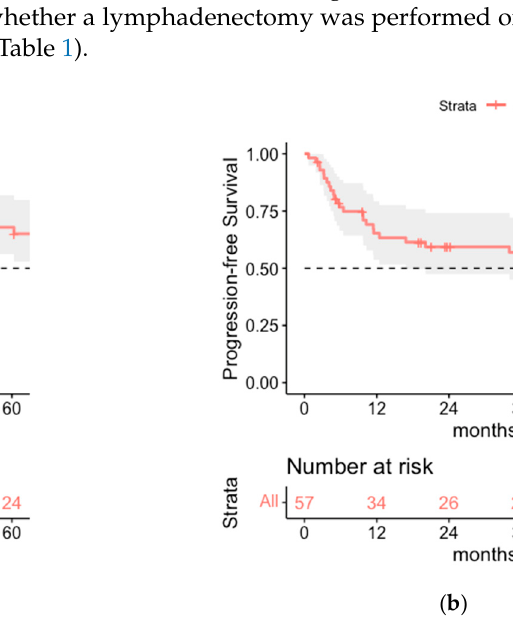
Figure 1. ( a ) Overall survival (OS) and ( b ) progression-free survival (PFS) of the total cohort (n = 57). Median OS was 112 months, median PFS was 60.4 months.